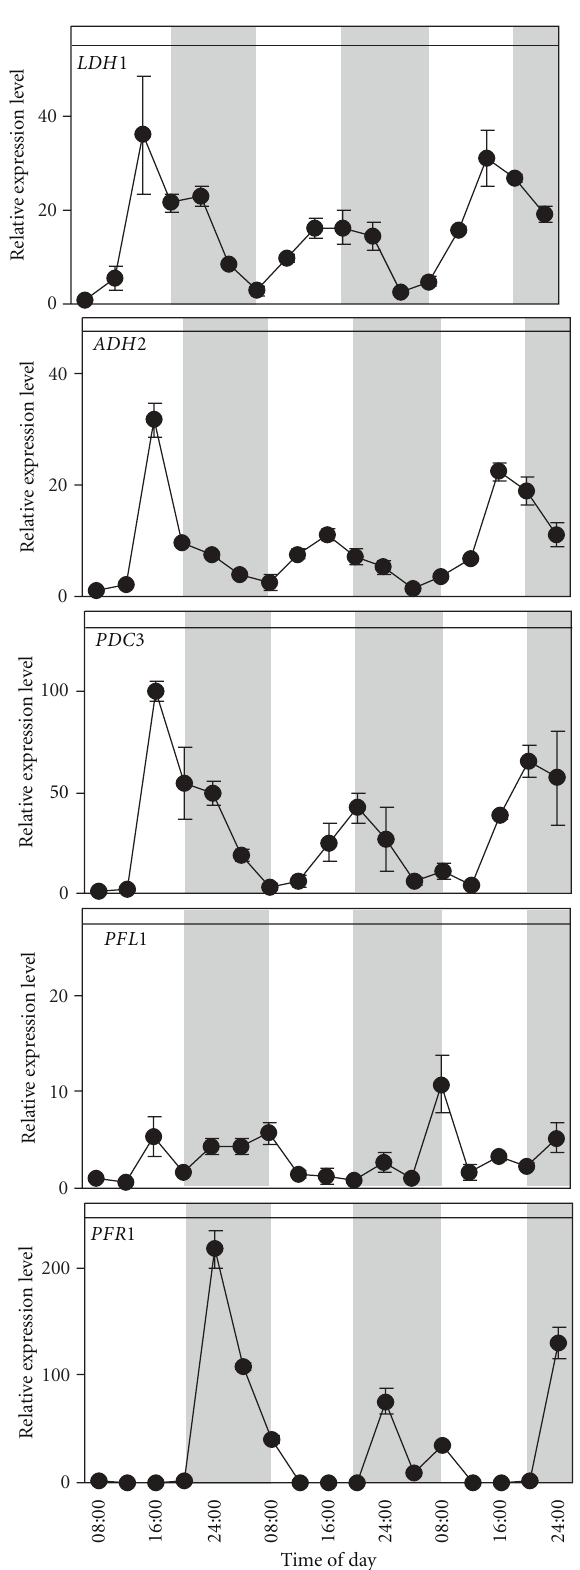
Figure 1: Expression patterns for LDH1, ADH2, PDC3, PFL1, and PFR1 in synchronized Chlamydomonas cells over 3 cycles of day and night in control conditions (12h: 12h light :dark photoperiod; 23 ◦ C), with samples taken every 4 hours. Relative expression levels were measured by real-time reverse-transcription polymerase chain reaction (qPCR) (1 = the value of expression measured at the first data point which corresponds to 8:00 on the first day). Data are mean ± SD, n = 3 replicates. When not shown, the error bars were smaller than the